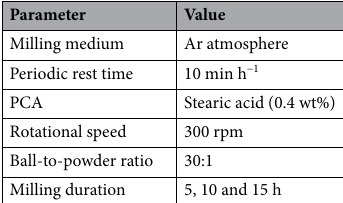
Table 2. Process parameters of ball-milling to obtain nanocrystalline MCrAlY feedstock powder.